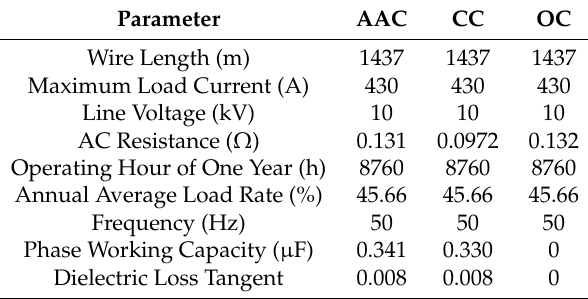
Table 2. Physical parameters in Case 1.